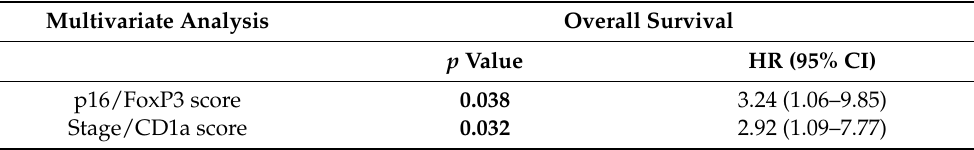
Table 8. Multivariate analysis evaluating the correlation between the p16/FoxP3 score, stage/CD1a score and patient survival. p values < 0.05 are highlighted in